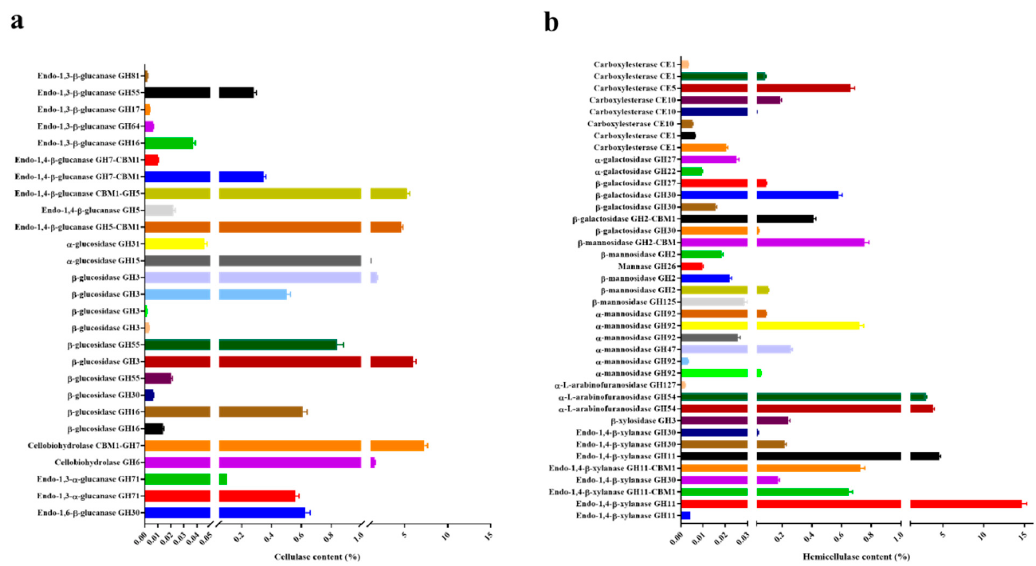
Figure 3. Cellulase and hemicellulase abundance in the proteome of T. harzianum EM0925. ( a ) Cellulase content in the proteome of T. harzianum EM0925; ( b ) hemicellulase content in the proteome of T. harzianum EM0925.